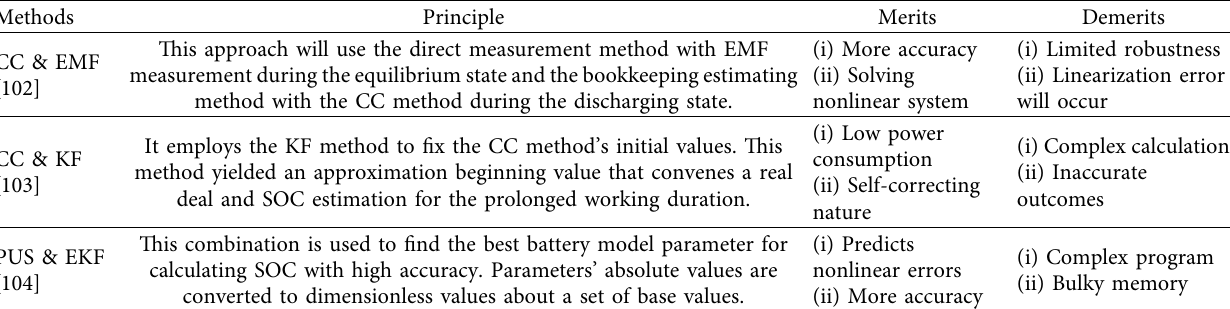
Table 6: Comparison of the hybrid model of SOC estimation.